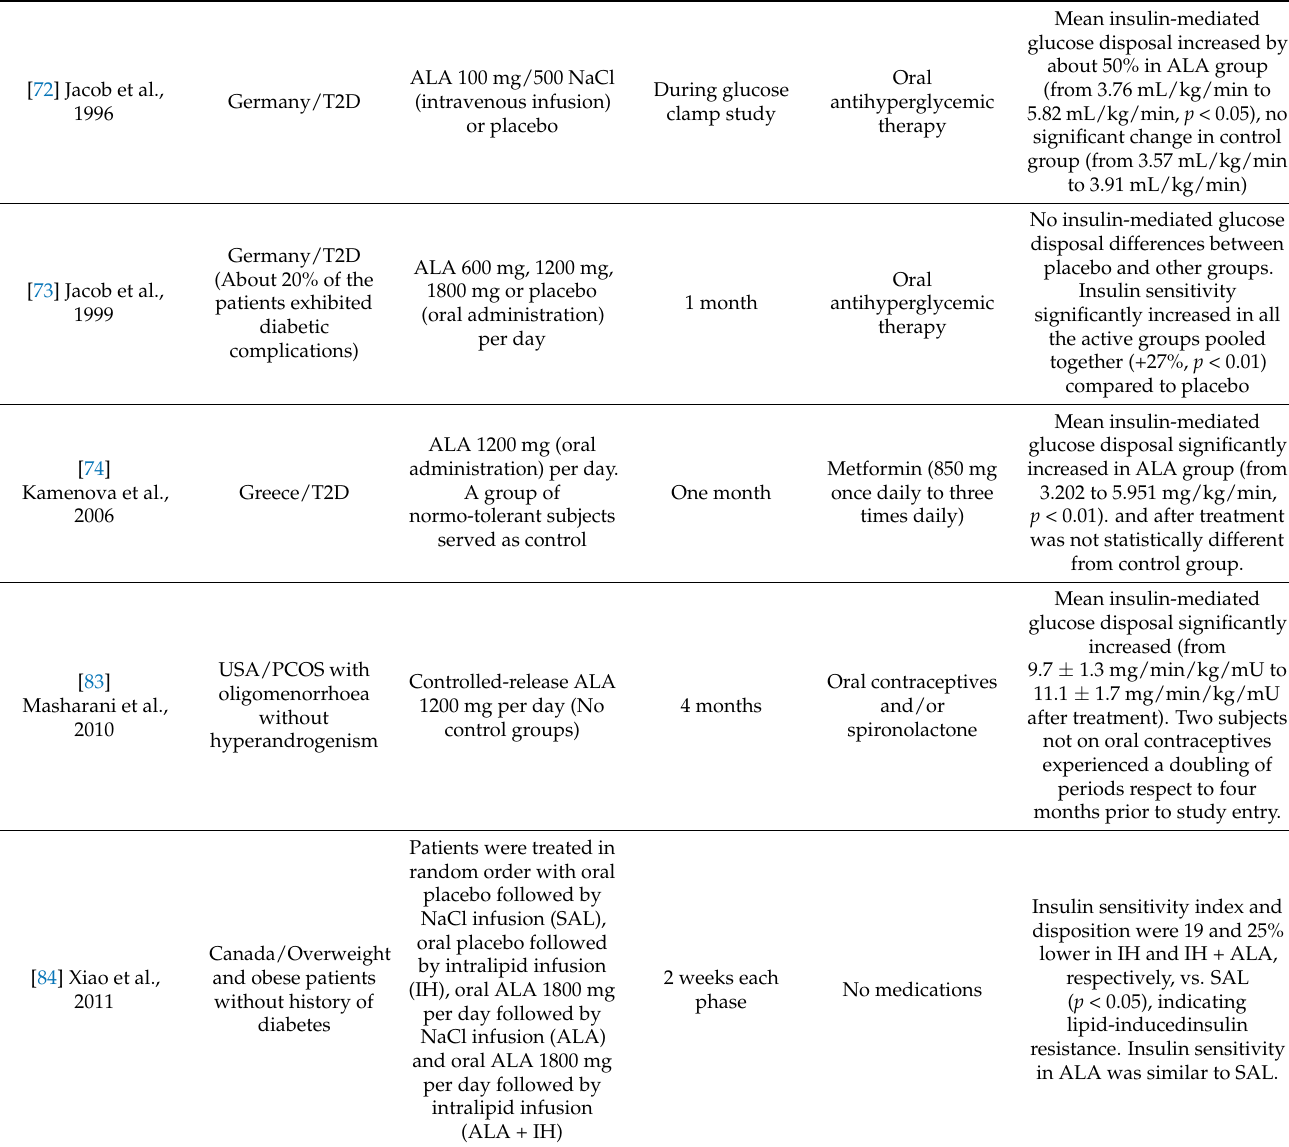
Table 2. Studies on ALA’s effect on insulin sensitivity (M and insulin sensitivity indexes) **.